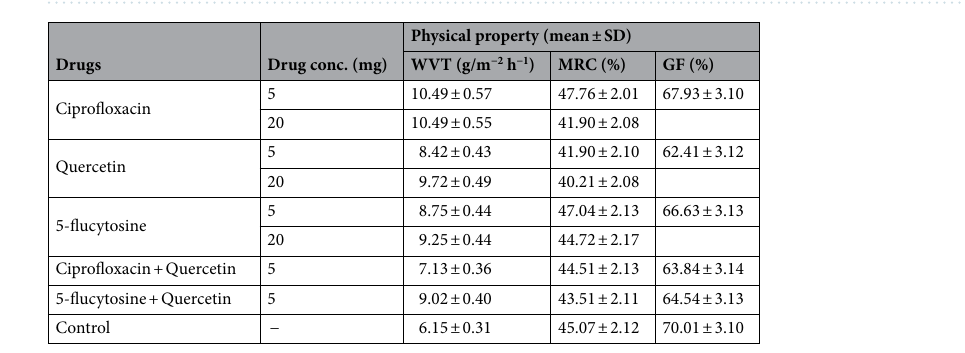
Figure 2. Characterization of the GbH: The physical evaluation of GbH: ( a ) the swelling behaviour of GbH in water, NaCl solution, MgCl 2 solution and blood. The SEM image: ( b ) and ( c ) control GbH with pore size range from 266-393 nm; ( b.1 ) antibacterial ciprofloxacin drug-loaded GbH; ( b.2 ) wound healing promoting quercetin drug-loaded GbH; ( b.3 ) antifungal drug 5-flucytosine loaded GbH; ( b.4 ) Combination of antibacterial drug ciprofloxacin and quercetin loaded GbH. ( c.1 ) SEM image of patch-A GbH before the release of salicylic acid; ( c.2 ) SEM image of patch-A GbH after the release of salicylic acid ( c.3 ) SEM image of patch-B GbH before the release of salicylic acid; ( c.4 ) SEM image of patch-B GbH after the release of salicylic acid. Surface functional characteristics illustrated: ( d ) FT-IR of standard hydrogel and GbH; ( e ) FT-IR of GbH with antibacterial drug ciprofloxacin (C) loaded, wound healing promoting drug, quercetin loaded (Q), GbH with antifungal drug 5-flucytosine (5F) loaded, GbH with antibacterial drug ciprofloxacin and quercetin combined (Q + C) loaded and GbH with antifungal drug 5-flucytosine and quercetin combined (Q + 5F) loaded; ( f ) FT-IR of patch-A and -B. DSC characterization of patches: ( g ) GbH and ( h ) patch-A and -B. ( i ) XRD of the GbH as patch-A and -B.